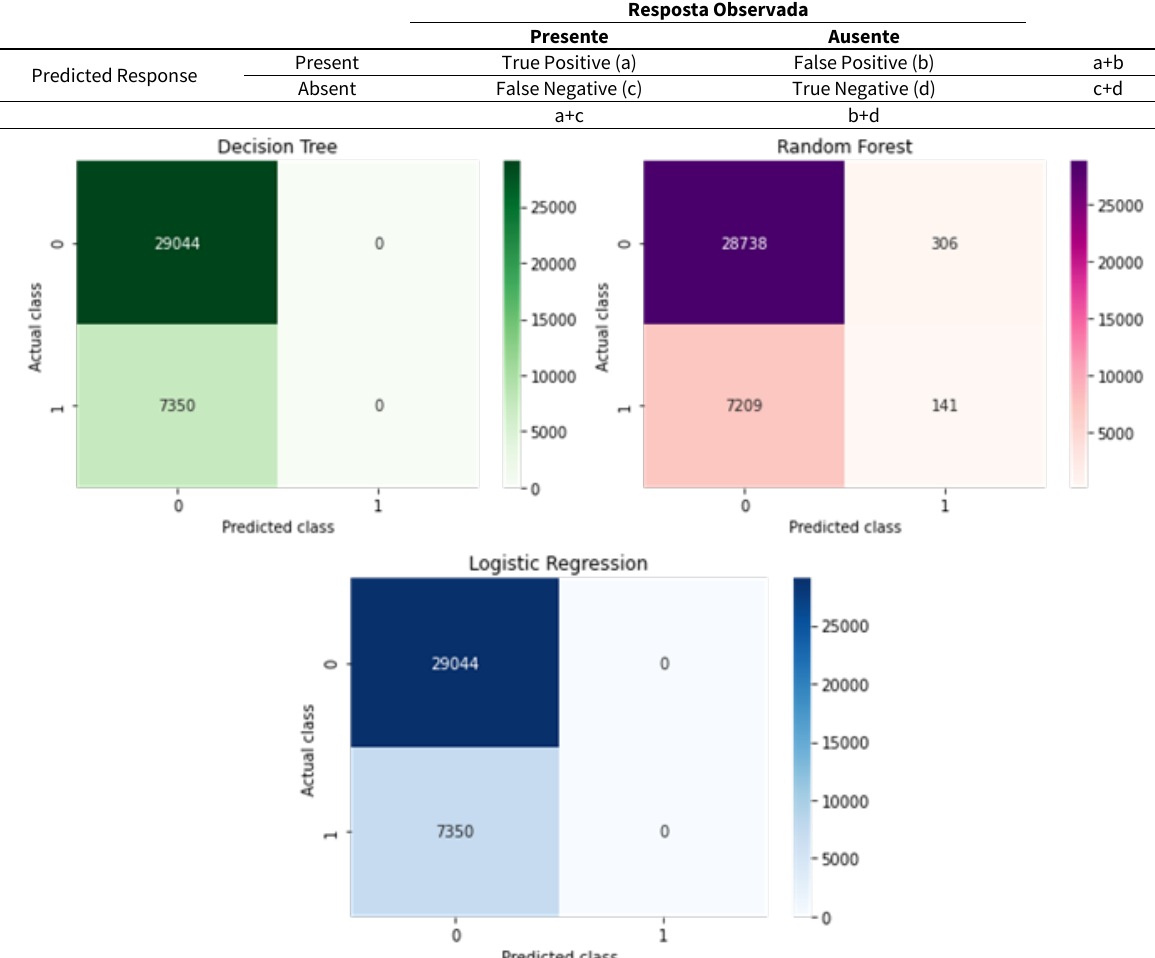
Table 2. Confusion Matrix for Classification Problems (Deng et al., 2016)